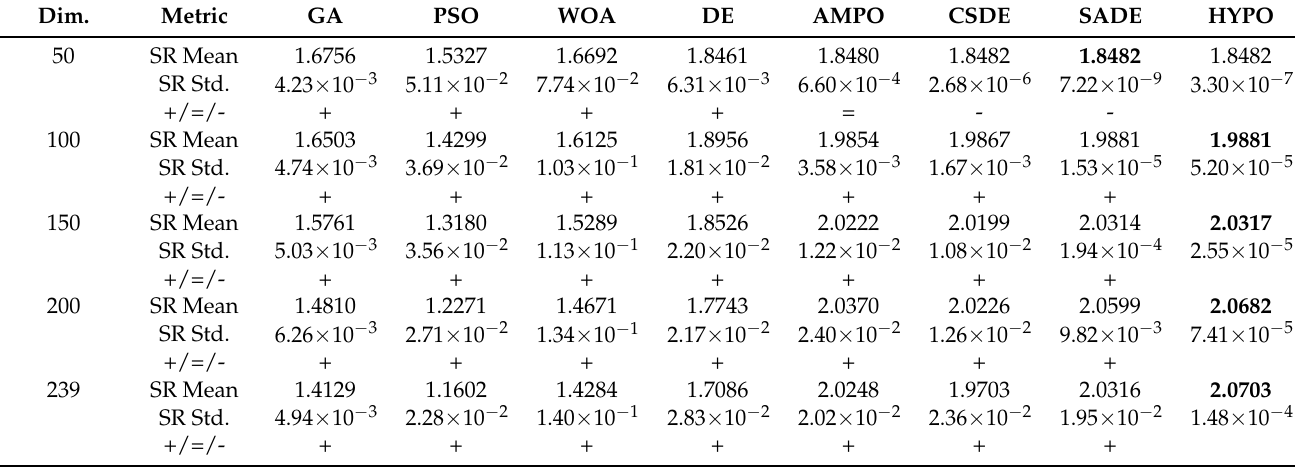
Table 7. Comparative Results on the CSI300